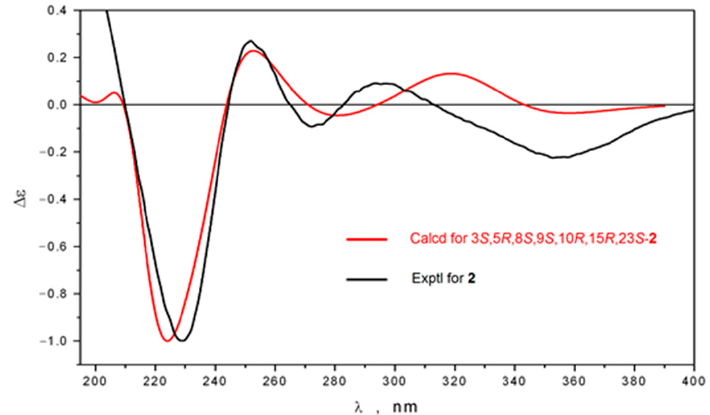
Figure 4. Comparison of experimental and theoretical ECD spectra of stellettin R ( 2 ).